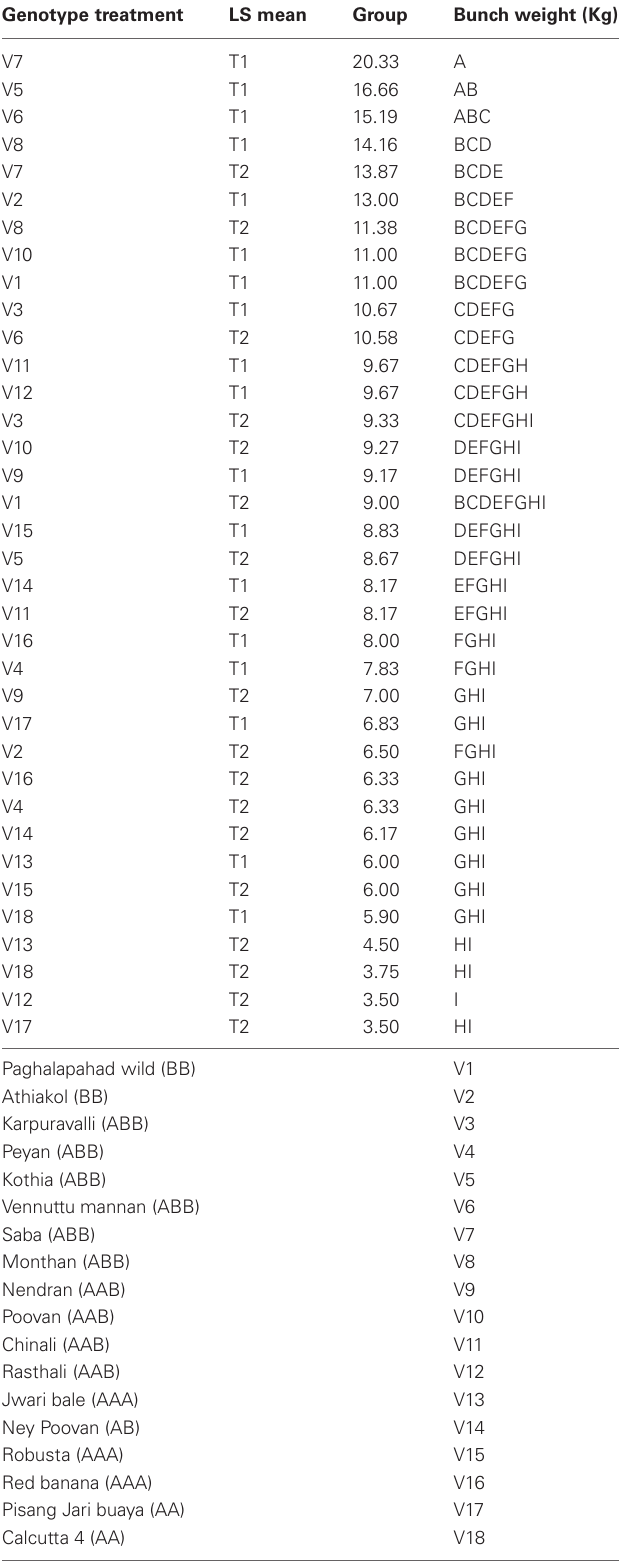
Table 3 | Effect of drought stress on banana bunch weight ( V × T